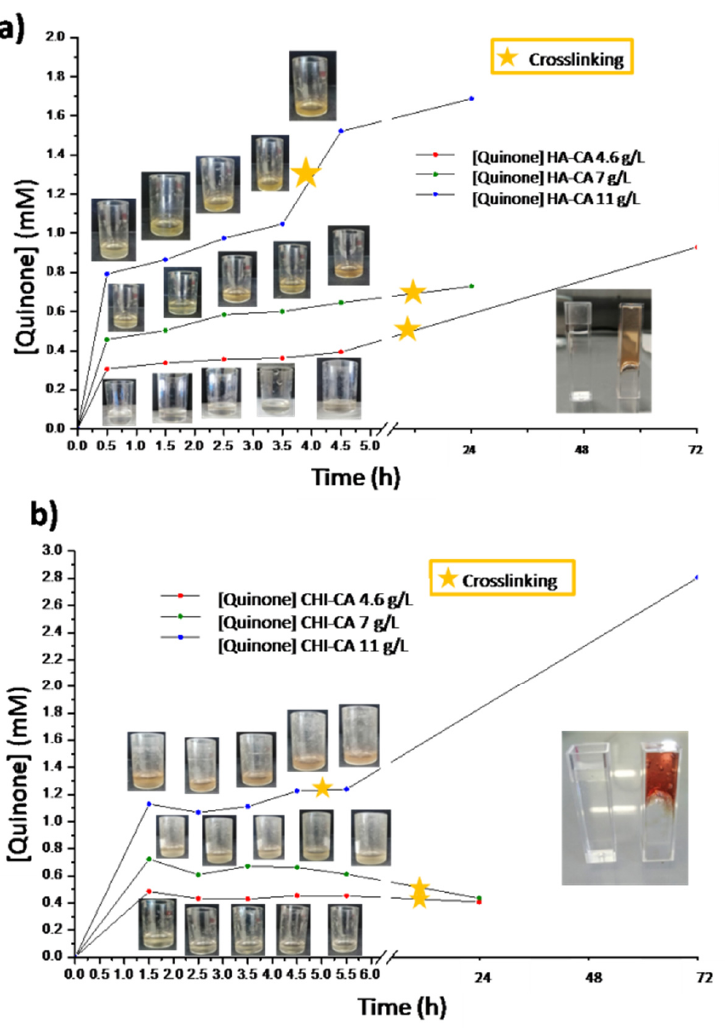
Figure 8. Quinone concentration over the time in ( a ) HA-CA and ( b ) CHI-CA samples calculated from calibration. In addition, a yellow star indicates the gelation time determined by the vial inversion method.